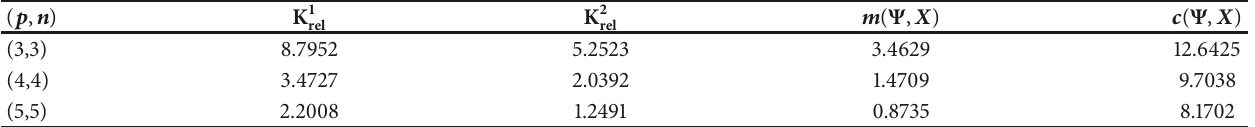
Table 3: Normwise and mixed condition numbers evaluated at different doubly stochastic input matrix 𝐴 .